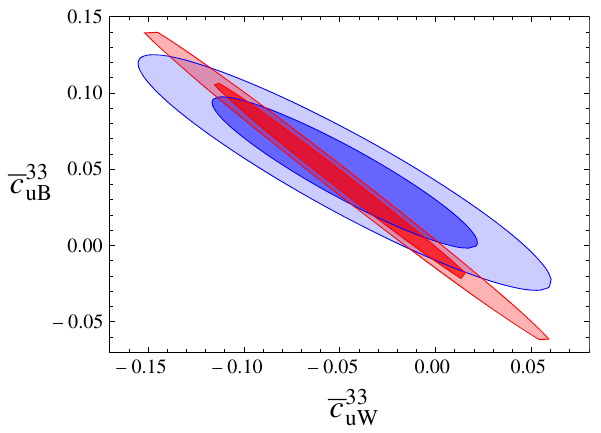
Fig. 9 Contour of the S , T , U fit reported in [53] for specifically the , O operators O , which are unconstrained by down-sector mea- uW uB surements. All other Wilson coefficients are chosen to be zero. The dark and light shaded areas represent 68 and 95% confidence levels for this projections, while the blue contour uses μ R = m Z and the red contour μ R = 1 TeV